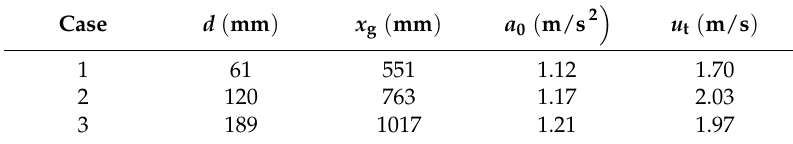
Table 1. Parameters for the 3-D submerged landslide simulations given in Enet and Grilli [6].